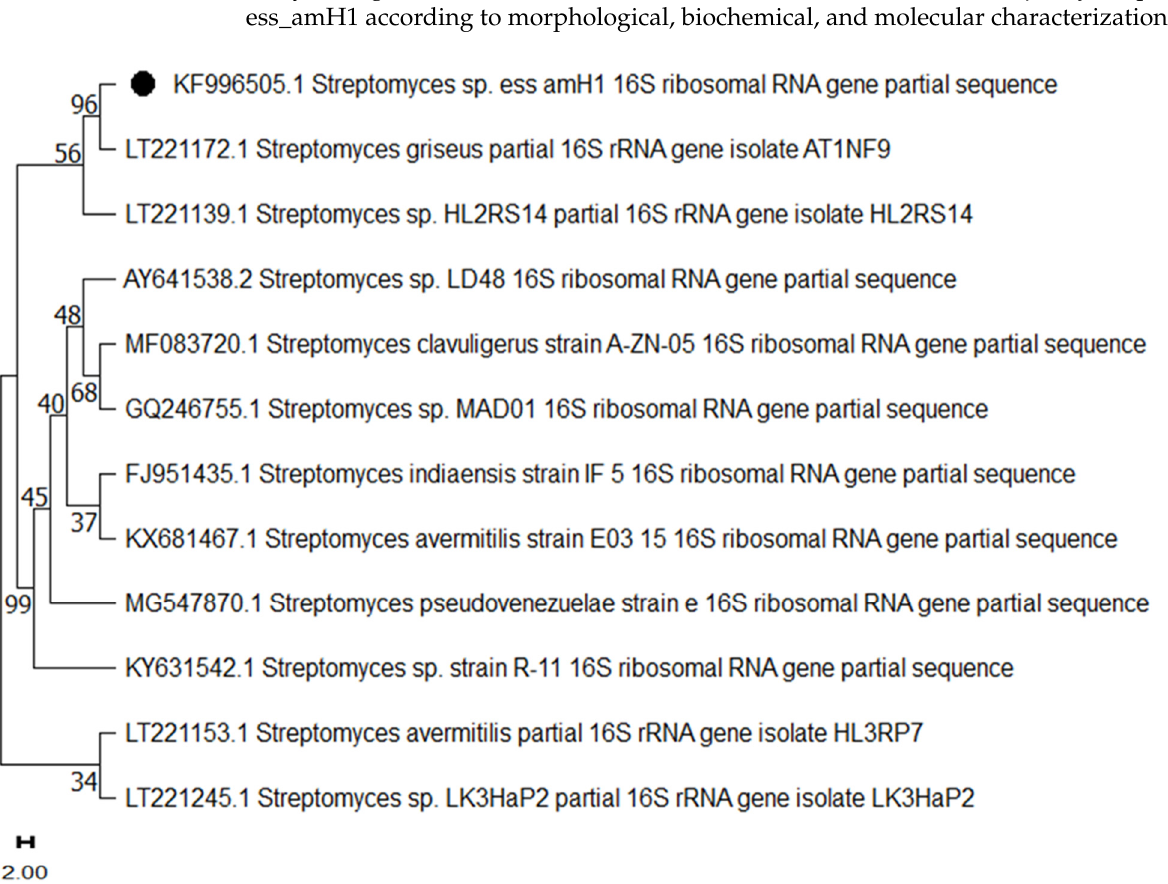
Figure 4. Phylogenetic analysis of Streptomyces sp. strain ess_amH1. The phylogenetic tree was constructed on the basis of the 16s rRNA sequences using the maximum likelihood method and Tamura–Nei model in MEGA 11.0.13. The percentage of replicate trees in which the associated taxa clustered together in the bootstrap test (1000 replicates) is shown next to the branches. Branches corresponding to partitions reproduced in less than 50% bootstrap replicates are collapsed.